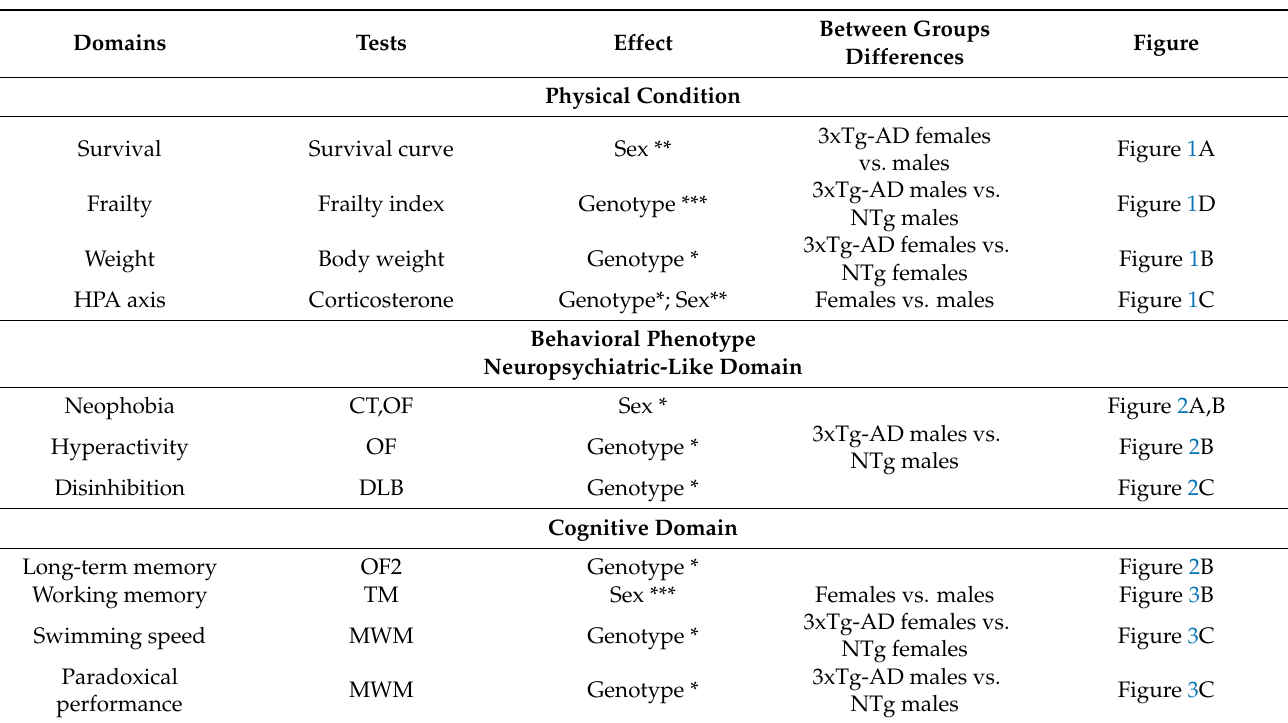
Table 1. Synopsys of main genotype and sex effects in the physical condition and behavioral phenotype.